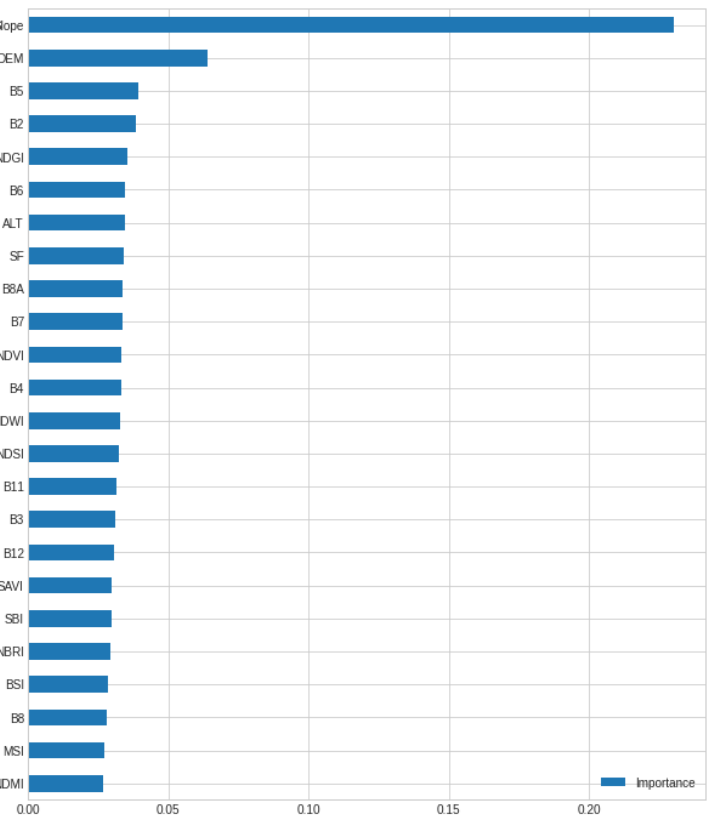
Figure 7. Feature importance calculated for 10 bands (B2–B8, B8A, B11, B12), 12 spectral indices, DEM and slope in a landslide susceptibility classification